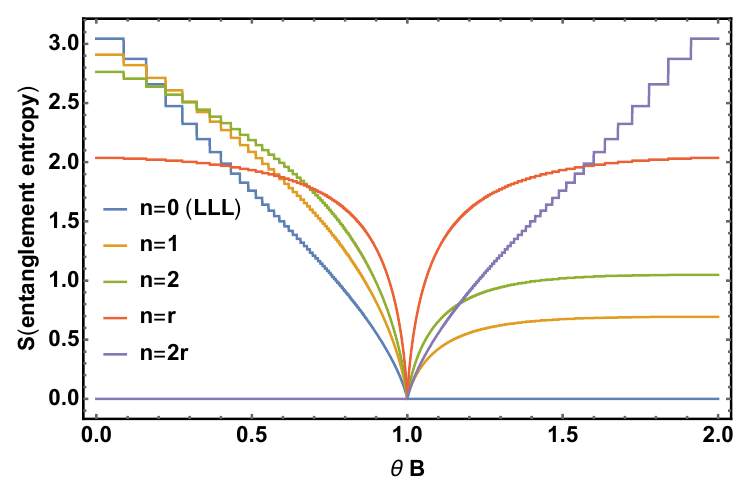
Figure 4: Entanglement entropy as a function of magnetic field for the noncommu- tative sphere case for LL index n = 0,1,2, r ,2 r . The step like structures are due to the monopole quantization on the spherical